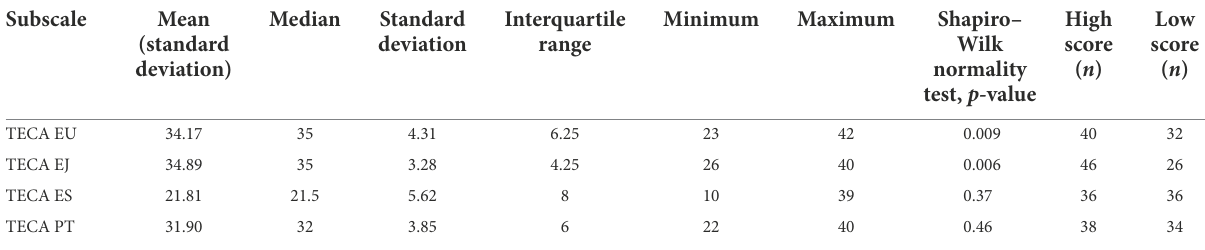
EU, emotional understanding; EJ, empathetic joy; ES, empathetic stress; PT, perspective-taking. The last two columns show the number of participants in each category after discretizing the scores according to the median score in each subscale. TABLE 5 Metrics of the best model achieved for each TECA subscale both in the validation and test sets. Subscale Model Features ( n